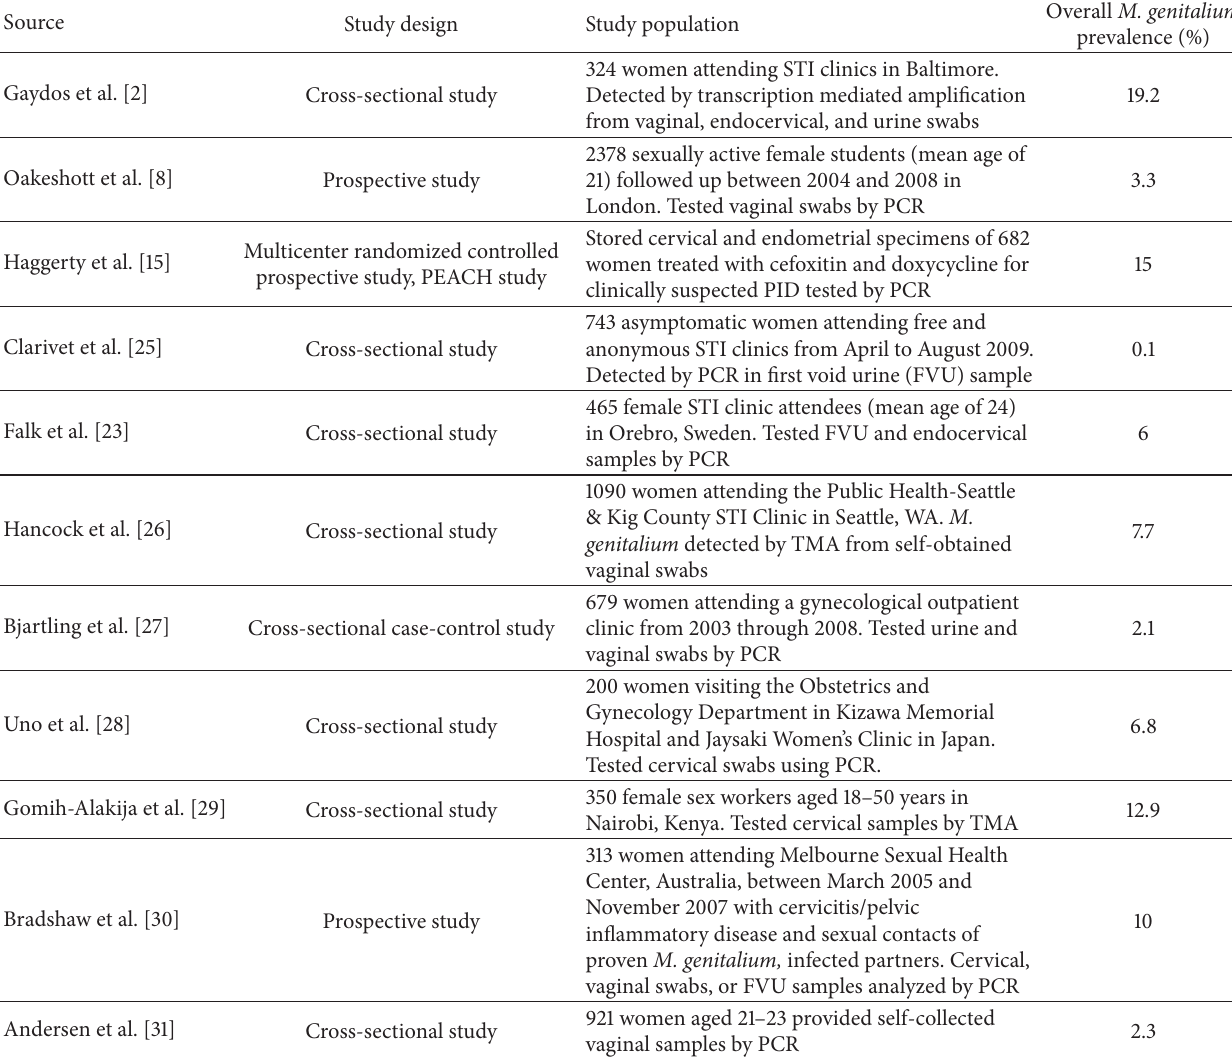
Table 1: Summary of M. genitalium prevalence according to various studies in